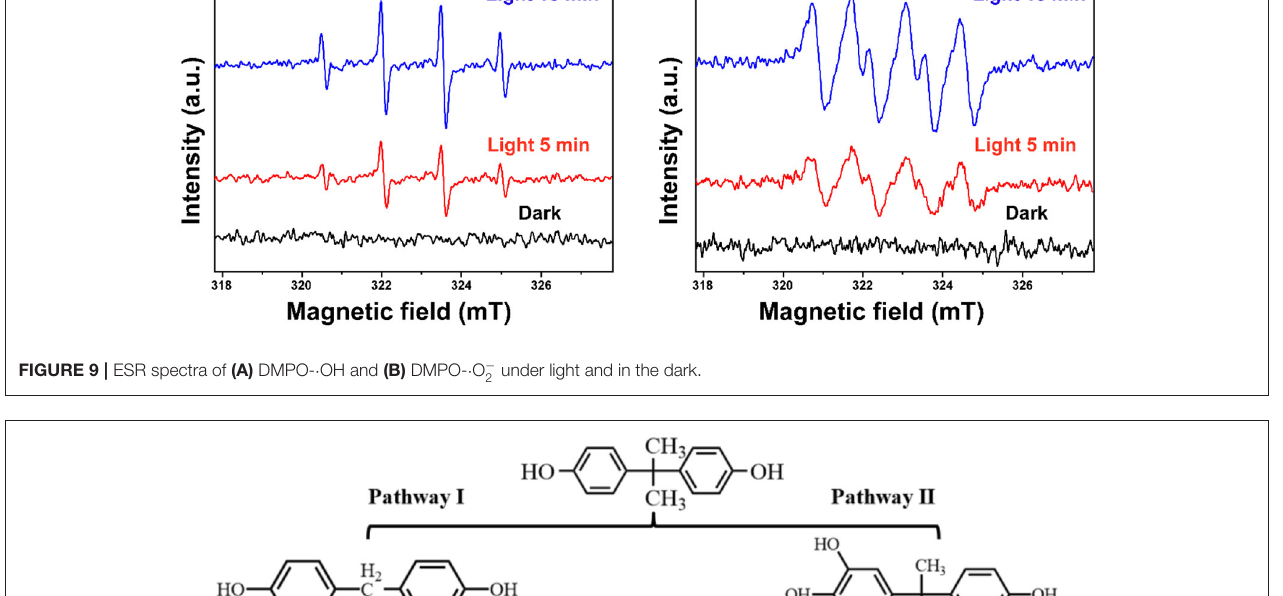
Frontiers in Bioengineering and Biotechnology |